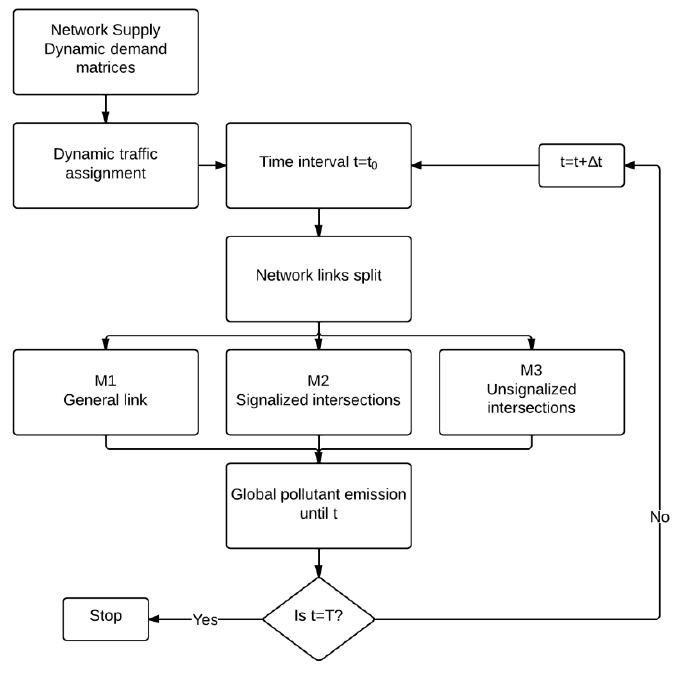
Figure 1. The architecture of the